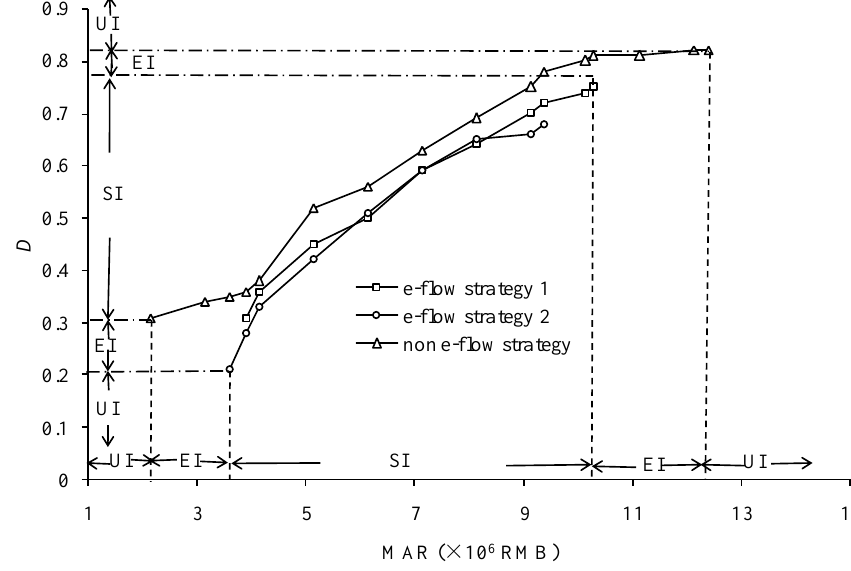
Fig. 1. Minimum degree of flow regime alteration for different planned mean revenues under three e-flow provision strategies. D is the degree of flow regime alteration; MAR is the mean annual revenue; UI is the unachievable interval; EI is the exclusive interval; SI is the shared